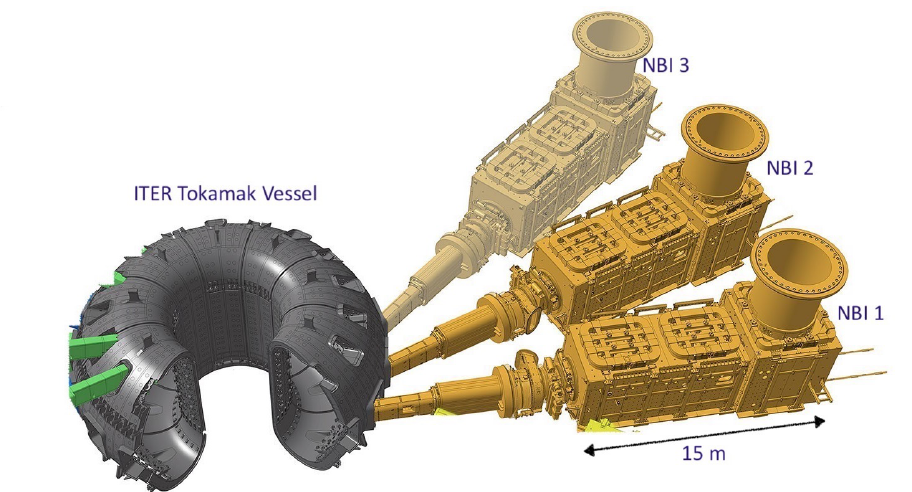
Figure 1. View showing the position of the 2 (+1) ITER NBIs (depicted in yellow) with respect to the ITER tokamak toroidal assembly. The volume of each NBI vacuum vessel, where the stray field shall be compensated, is about 15 × 2 × 2 m 3 ; the active correction and compensation coils are located just above and below each NBI vessel (3